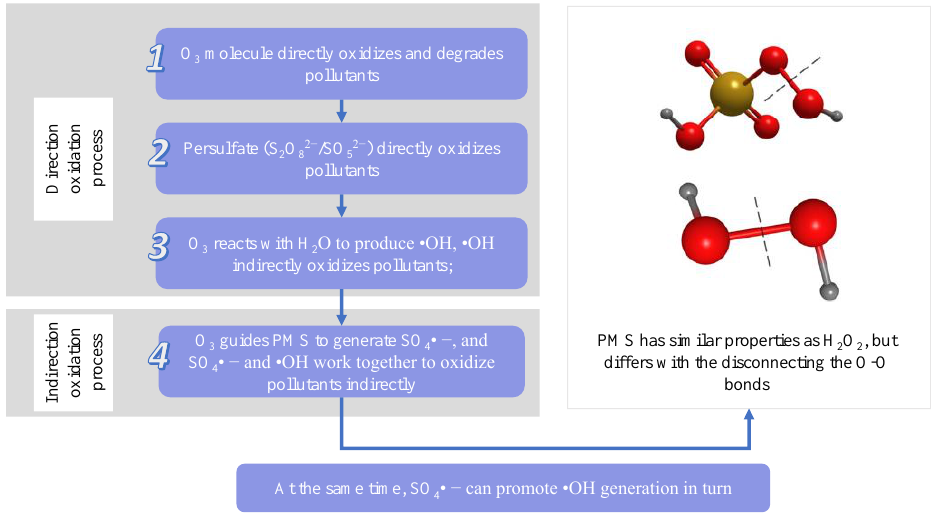
Figure 1. Free radical generation process in O 3 /PMS process and bond breaking of PMS and H 2 O 2 .